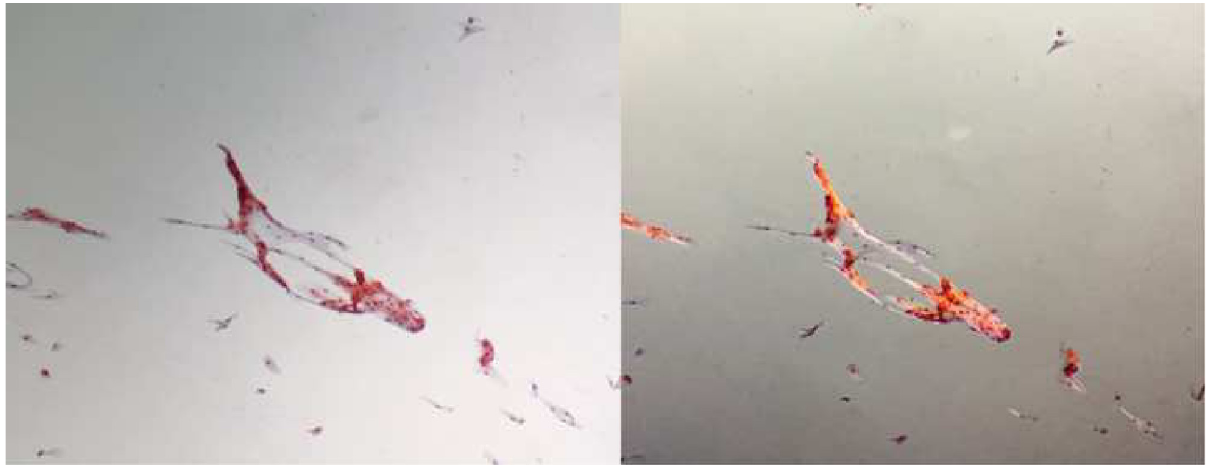
Figure 5: Oral mucosal exfoliated cells showing multiple deposits of amyloid, positive for Red Congo stain ( left ) and with yellow birefringence under polarized light ( right )